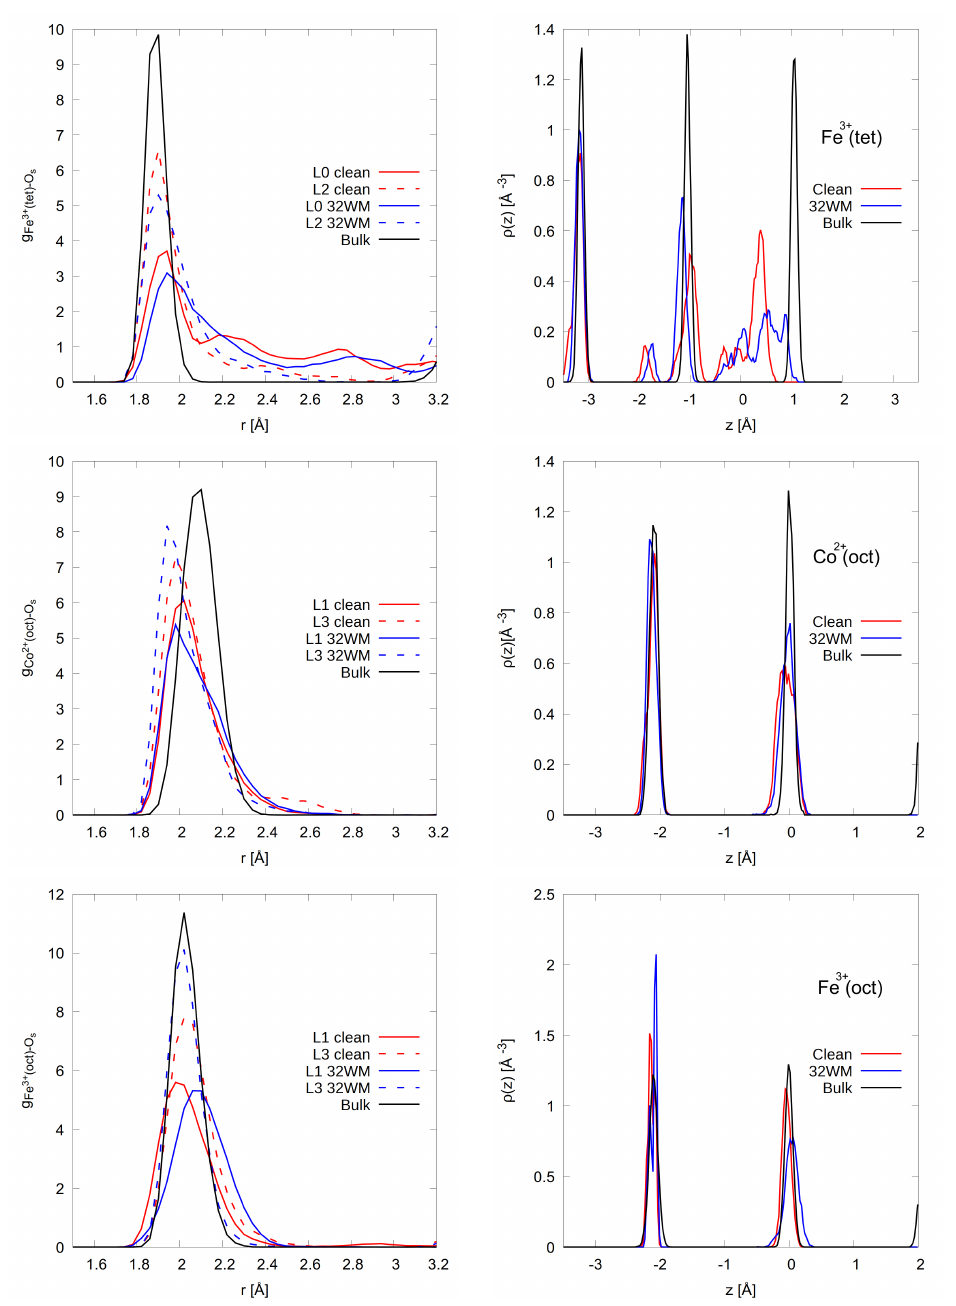
Figure 7. Radial distribution function ( left ) of the lattice oxygens to cobalt and iron ions in the 4 outermost layers (L0-L3) and density profiles ( right ) of the latter on the A-terminated surface. The center of mass of layer L1 (see Figure 1) is taken as reference position z =